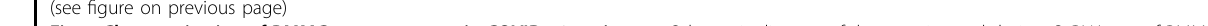
(Fig. 2k, l). In summary, the lymphoid progenitors decreased signi fi cantly, while EP increased signi fi cantly in patients with severe COVID-19. In addition, the propor- tions of GMP slightly rose in those mild or severe cases when compared with HC (Fig. 2j).